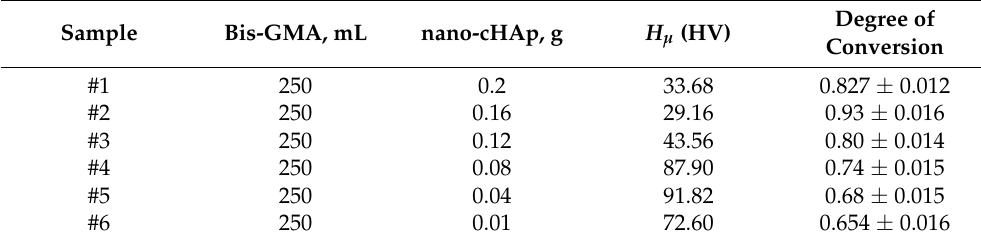
Table 1. Composition of the synthesised biomimetic adhesive